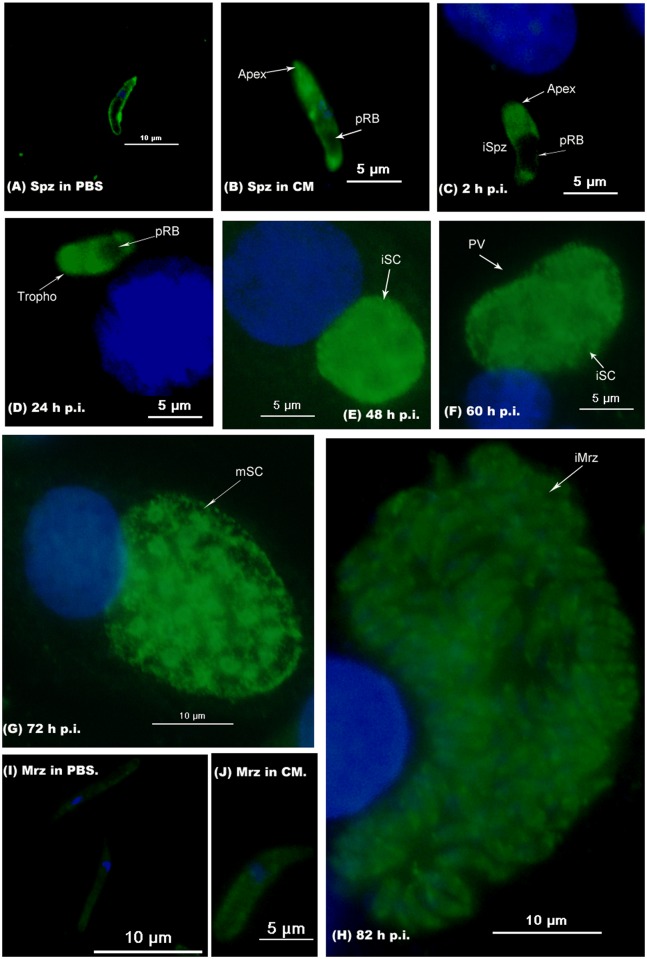
Localization of EtCHP559 in different stages of E. tenella by indirect immunofluorescence using rEtCHP559 antibody.(A) Sporozoites (Spz) in PBS; (B) Spz in complete medium. Infected DF-1 cells were collected at indicated times p.i.. (C) 2 h p.i., intracellular sporozoites (iSpz); (D) 24 h p.i., trophozoites (Tropho); (E) 48 h p.i., immature schizonts (iSC); (F) 60 h p.i., immature schizonts (iSC); (G) 72 h p.i., mature schizonts (mSC). (H) 82 h p.i., intracellular merozoites (iMrz); (I) Merozoites (Mrz) in PBS; (J) Merozoites (Mrz) in complete medium. pRB posterior refractile body, PV parasitophorous vacuole.